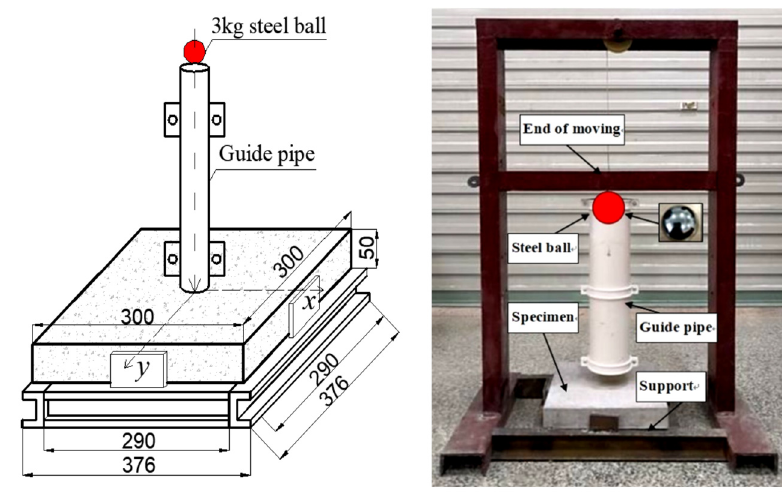
Figure 4. The drop weight impact test device of